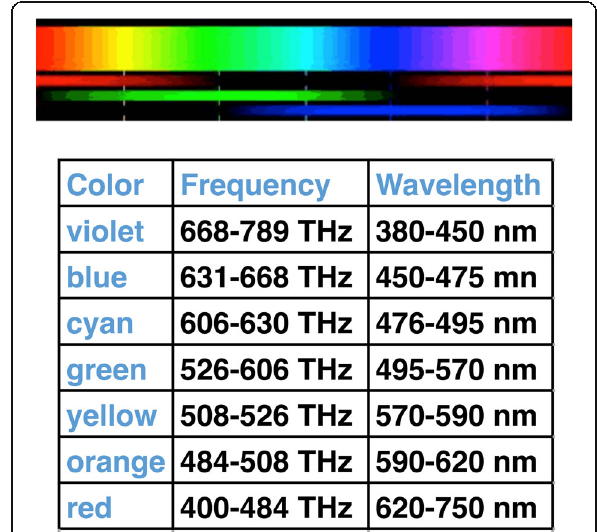
Fig. 9 Correlation analysis between green light and red light